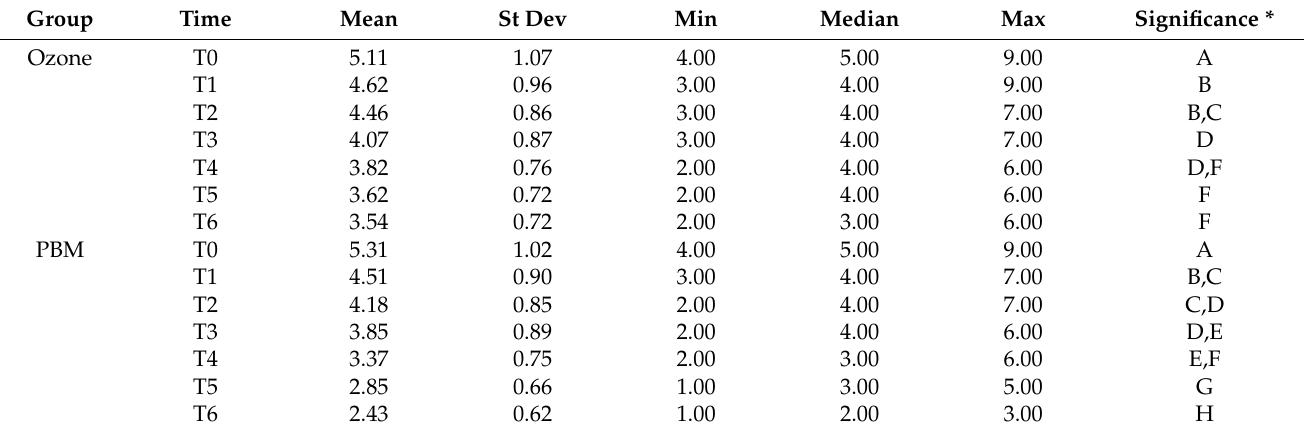
Table 3. Descriptive and inferential statistics of Probing Pocket Depth measurements (PPD).